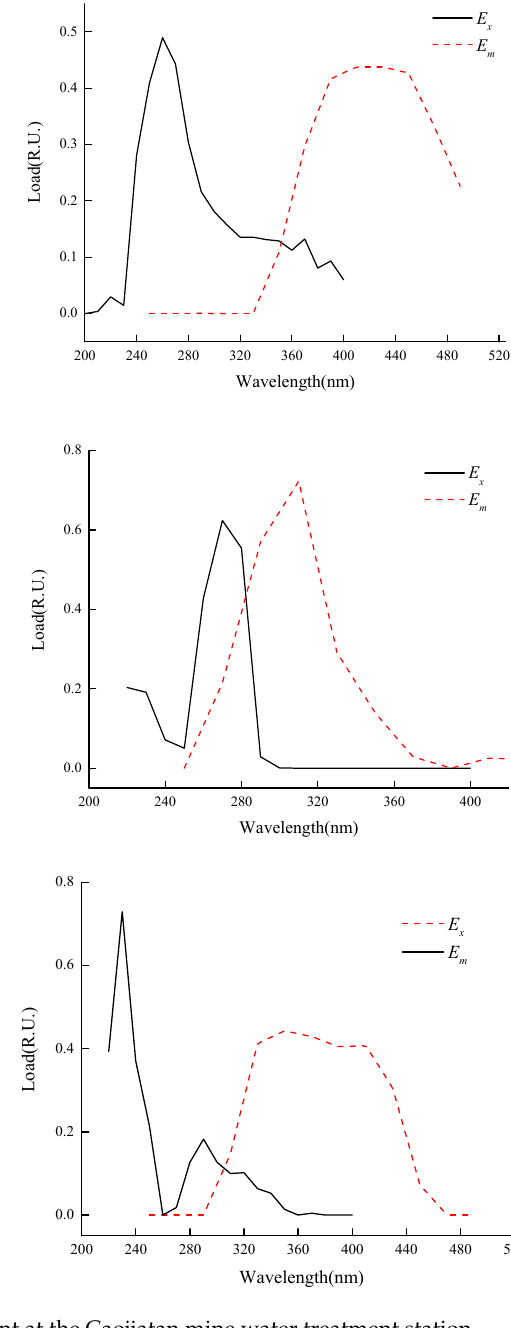
Figure 7. DOM characteristics of influent at the Caojiatan mine water treatment station.